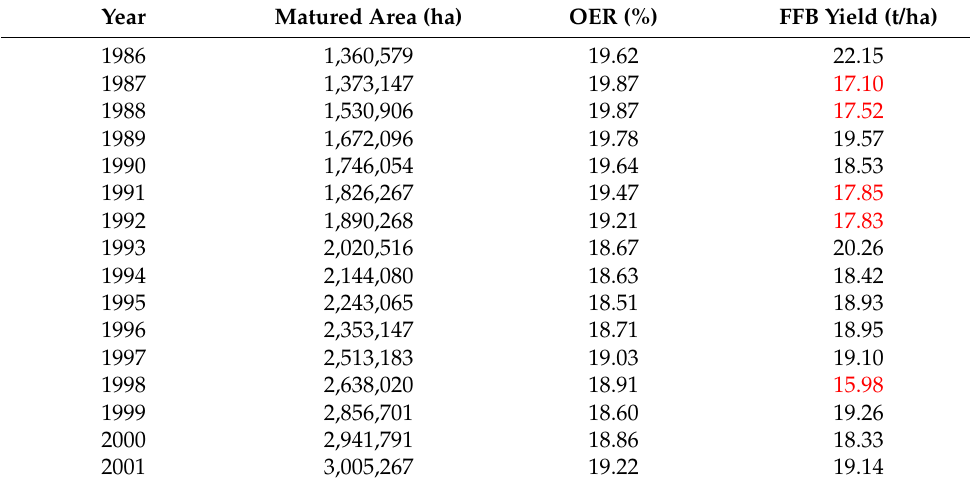
Table A7. Annual oil palm matured area, oil extraction rate (OER) and fresh fruit bunch (FFB) yield from 1986 to 2020 in Malaysia